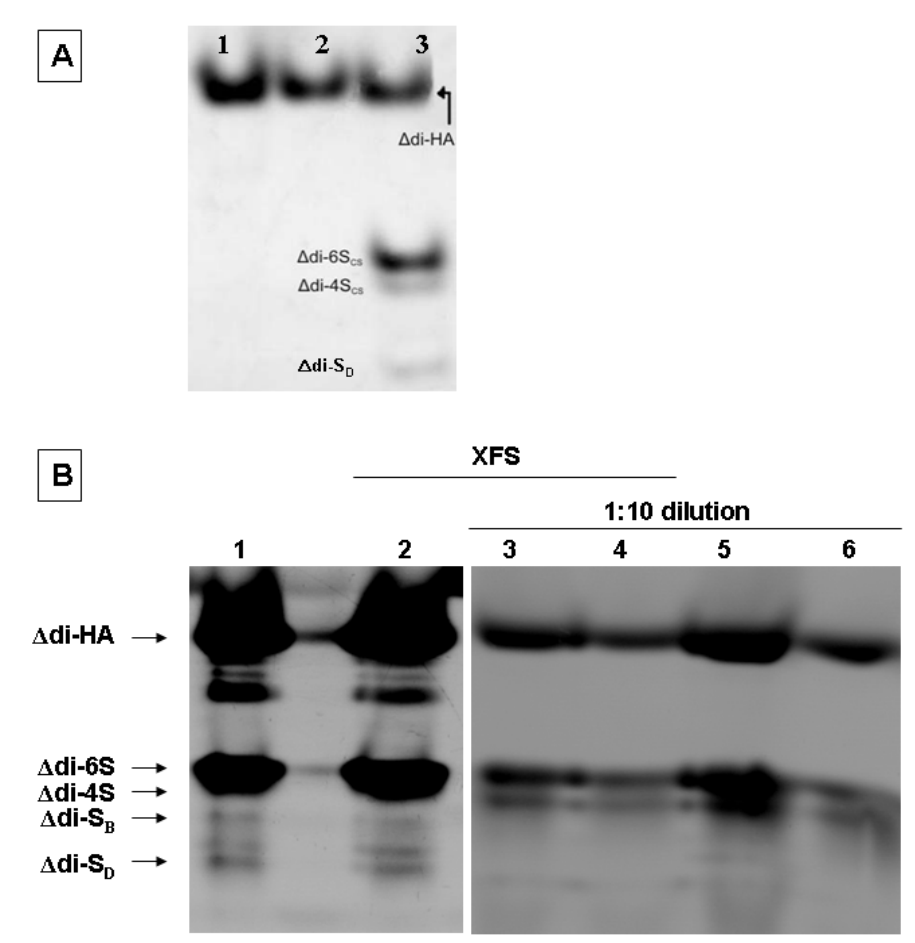
Figure 4. Panel ( A ): FACE analysis of high molecular weight hyaluronan (1), low molecular weight hyaluronan (2) and formulation Viscoat ® after enzymic digestion with chondroitinases ABC/ACII (3). Panel ( B ): FACE analysis of AMAC-derived disaccharide samples from lens capsules of patient donor with XFS before (lane 2) and after 1:10 sample dilution (lanes 3 and 4), and without XFS before (lane 1) and after 1:10 dilution (lanes 5 and